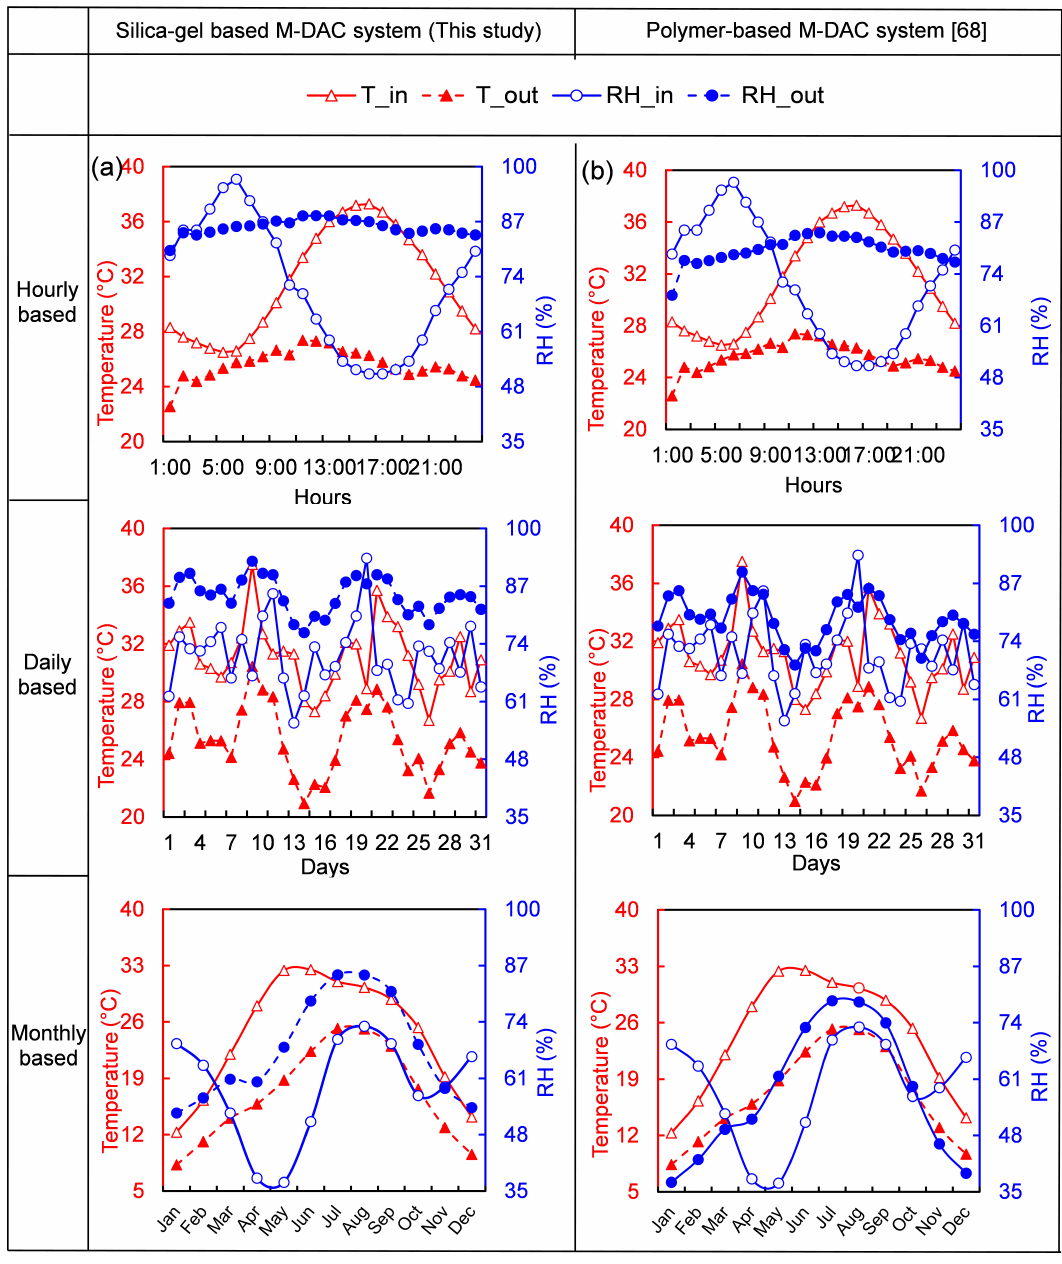
Figure 9. Thermodynamic performance of ( a ) silica-based DAC system with M-cycle unit, and ( b ) polymer-based DAC system with M-cycle unit on hourly, daily, and monthly basis for the climatic condition of Multan